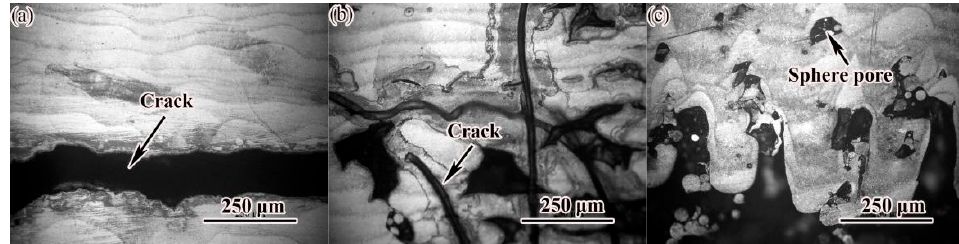
Figure 7. Types of defects at low laser power: ( a ) P = 150 W; V = 700 mm/s; ( b ) P = 150 W; V = 700 mm/s; ( c ) P = 150 W; V = 700 mm/s.